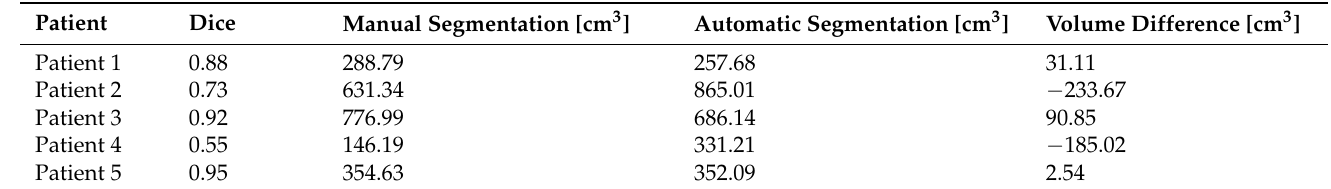
Table 4. The test set results for the 3D U-Net model. The dice coefficient, reference volume based on the manual segmentation, volume predicted by the model, and volume difference are presented for each patient.